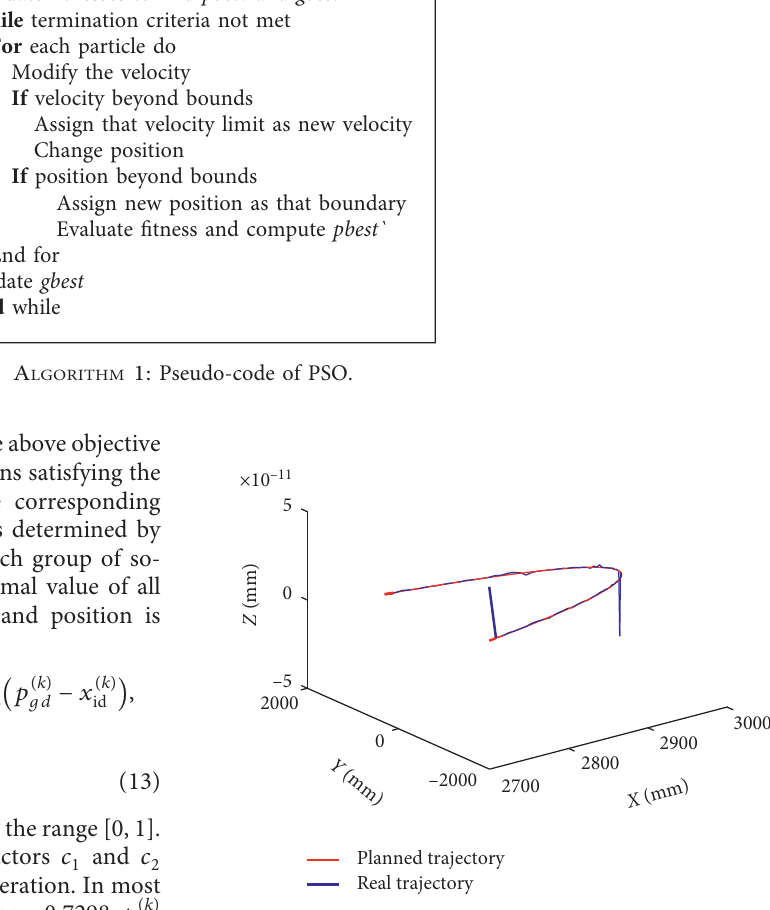
Figure 4: Planned trajectory and trajectory of the